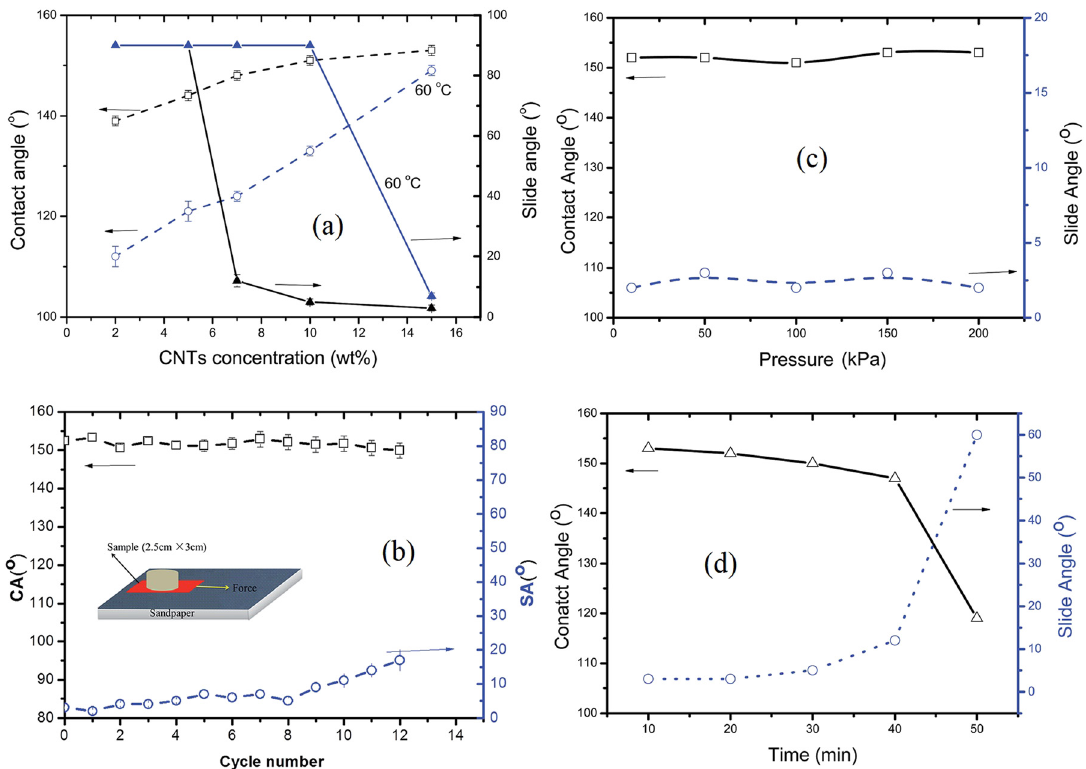
Figure 7: Variation of CAs and SAs of resin - coated samples with ( a ) concentration of CNTs, ( b ) abrasion cycles, ( c ) water pressure, and ( d ) duration of water - jet test under 200 kPa [ 140 ] . Reproduced with permission from ref. [ 140 ] ; © 2015 The Royal Society of